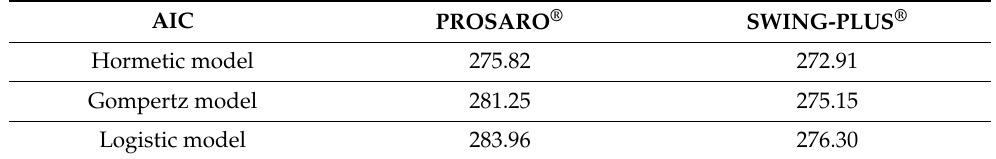
Table 5. Akaike information criteria (AIC) to determine the best-fitting model to estimate the inhibition concentration quantitative end-points based on results from Toxicity test 1.